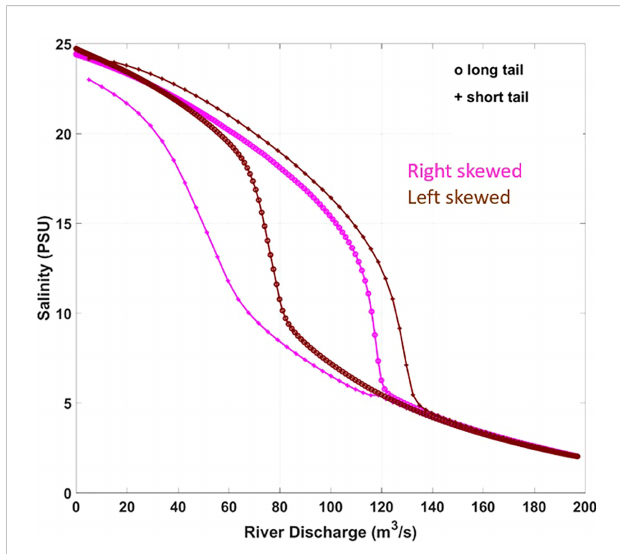
FIGURE 4 The mean over depth salinity averaged over a distance of 3 km far from the river mouth against the river discharge for the two skewed hydrographs. The circles correspond to the dates of the long tail and the crosses to those of the short